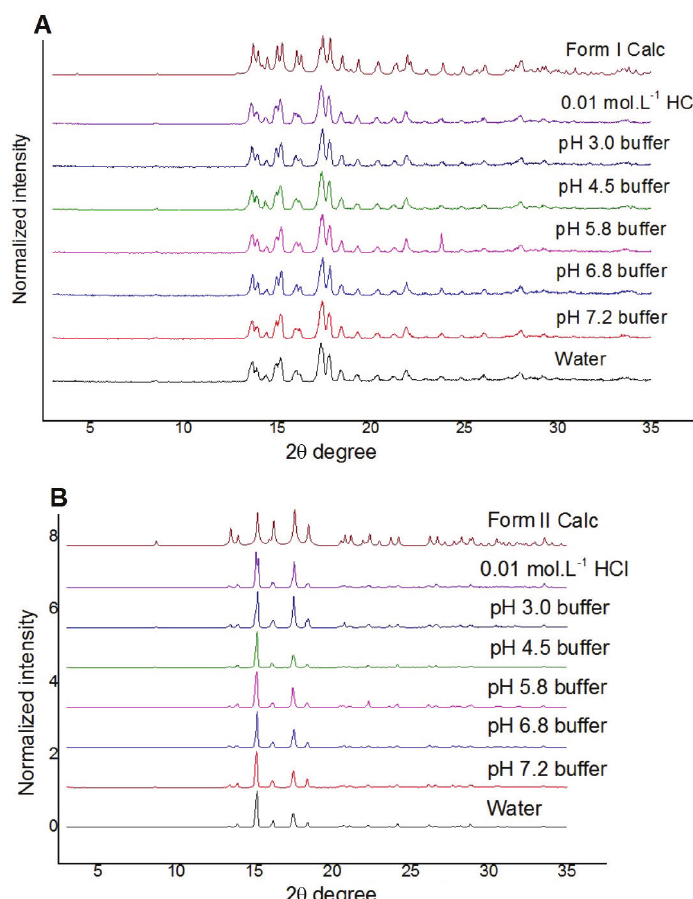
FIGURE 6 - Experimental PXRD patterns of the residual solid materials in equilibrium with the solution prepared from the tibolone forms I and II. The calculated PXRD pattern of the tibolone forms I and II are